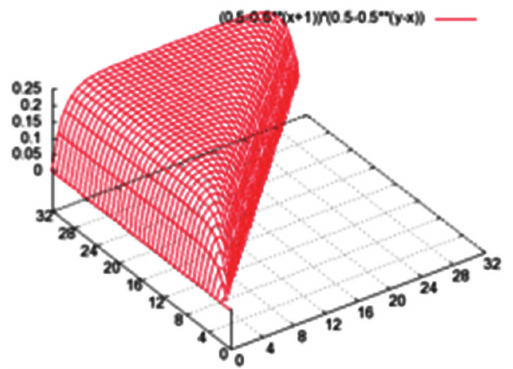
Figure 10: Distribution of the most probable estimation error for n -bit